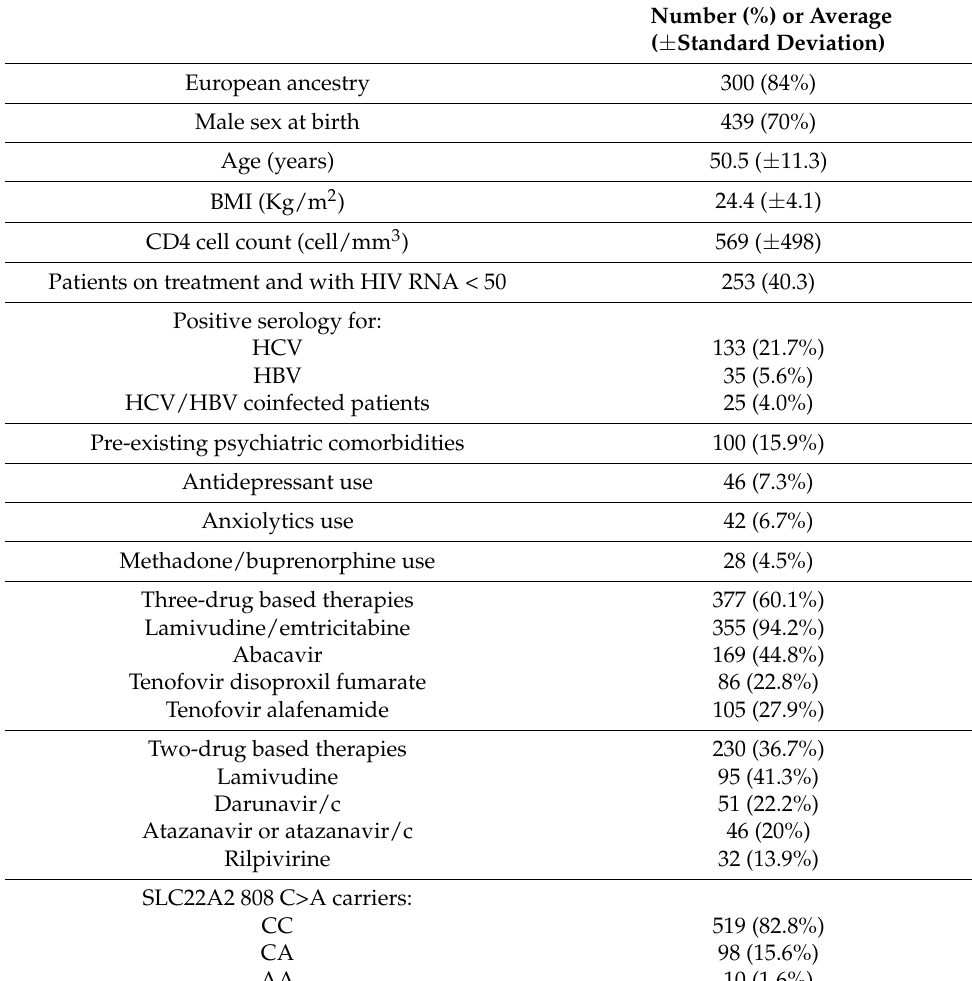
Table 1. Baseline characteristics of study